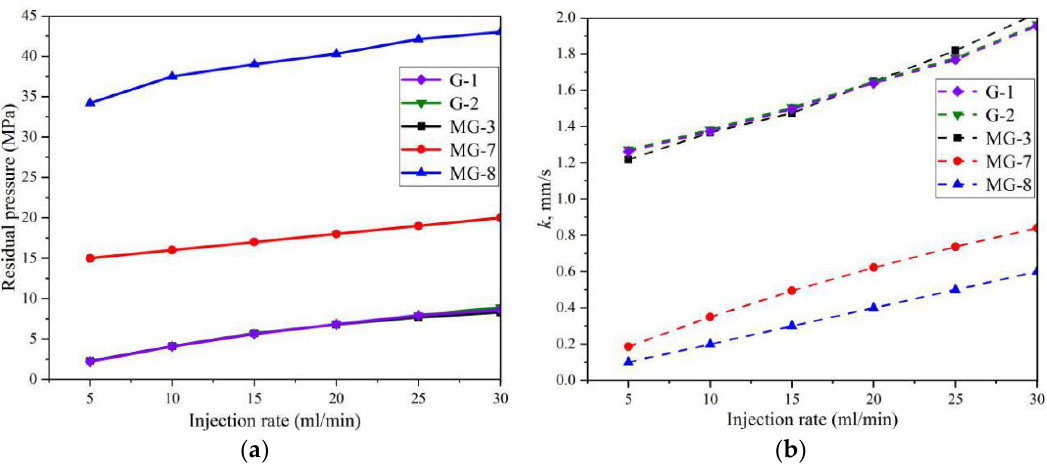
Figure 17. ( a ) Residual pressure and ( b ) conductivity of the induced cracks at different injection rates.